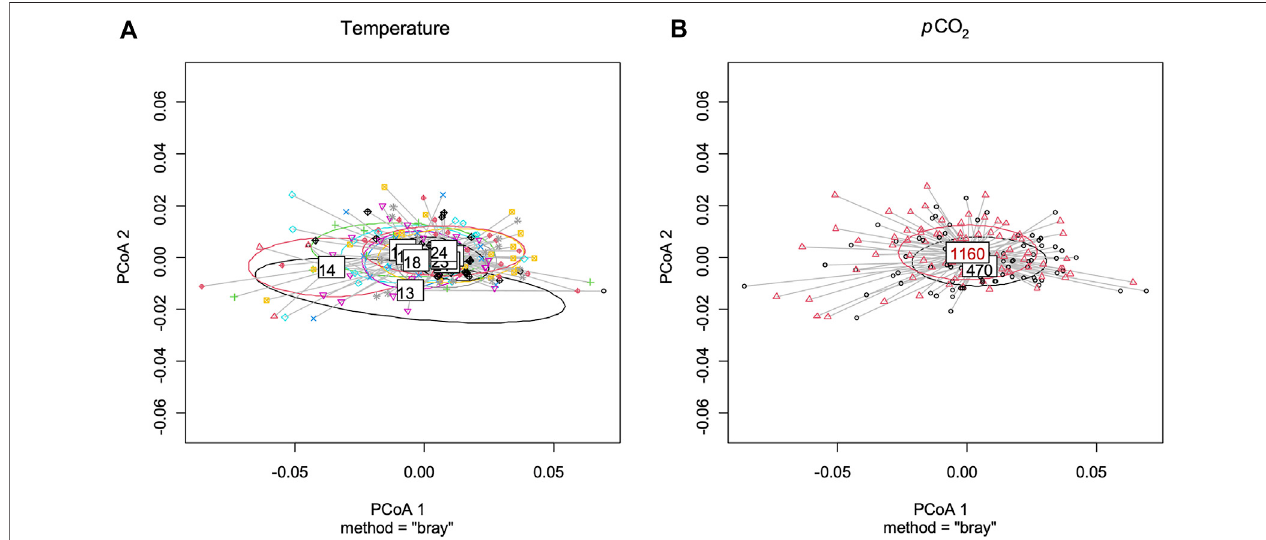
FIGURE5| Resultsofprincipalcoordinatesanalyses(PCoA)formorphologicaltraitsofstageIII Homarusgammarus larvae.Plotsweremadeusingrostrumlength, carapace length, abdomen length, total length and telson size. (A) comparison by temperatures (13 – 24 ° C), signi fi cant differences among temperatures. (PERMANOVA test: F1, 165 = 7.37, p = 0.003). (B) comparison by p CO 2 concentrations, no signi fi cance differences among p CO 2 concentrations.